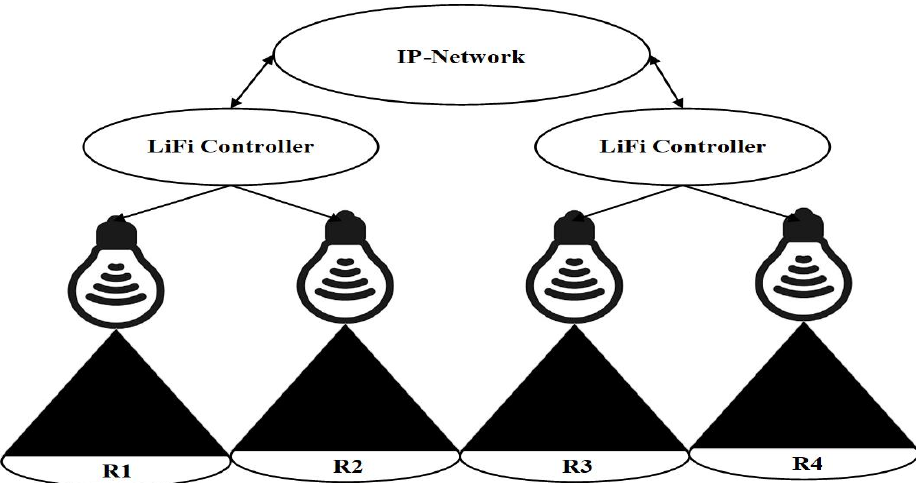
troller. Figure 2 present the considered hierarchal structure of a LiFi-based network.